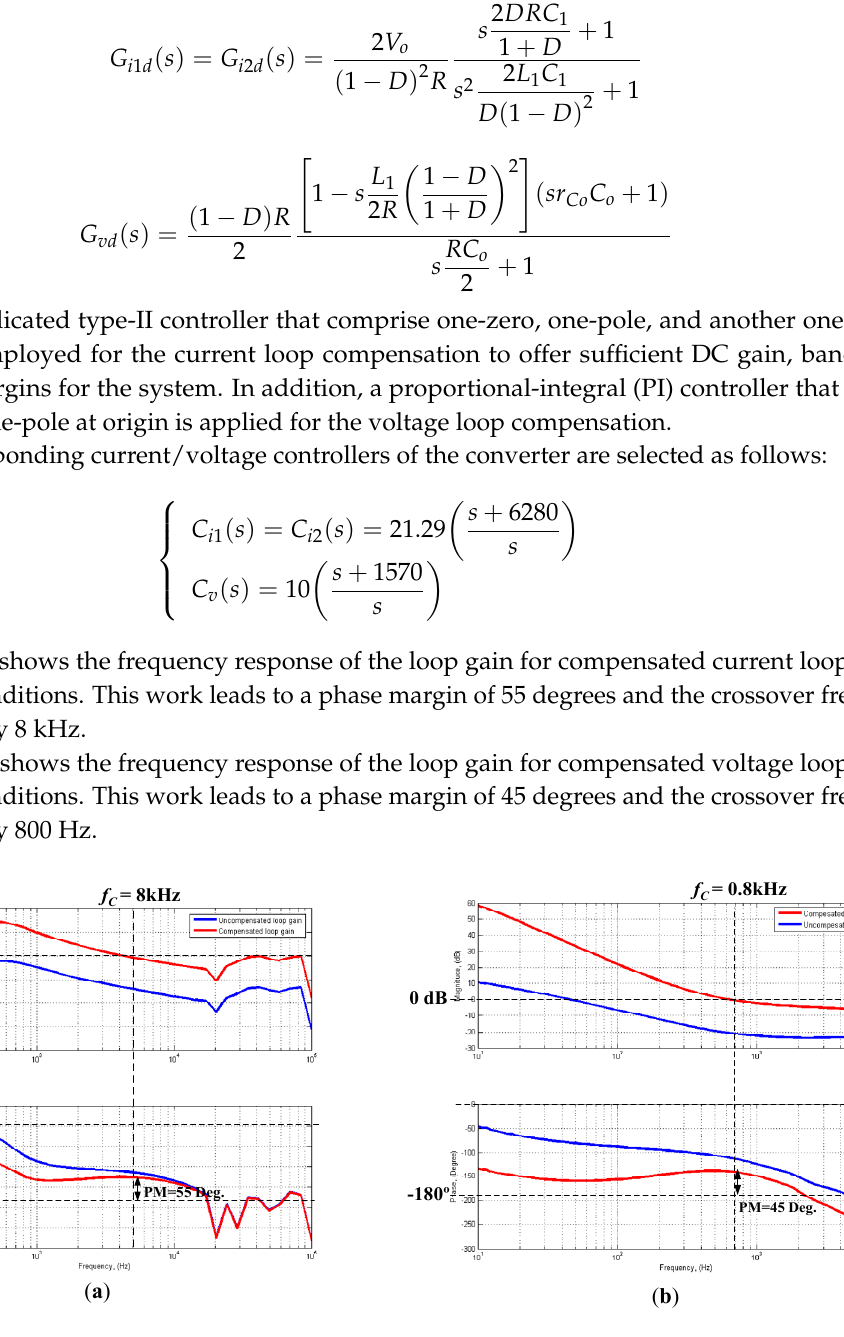
Figure 10. Frequency responses of the loop gain . ( a ) compensated current loop and ( b ) compensated voltage loop.